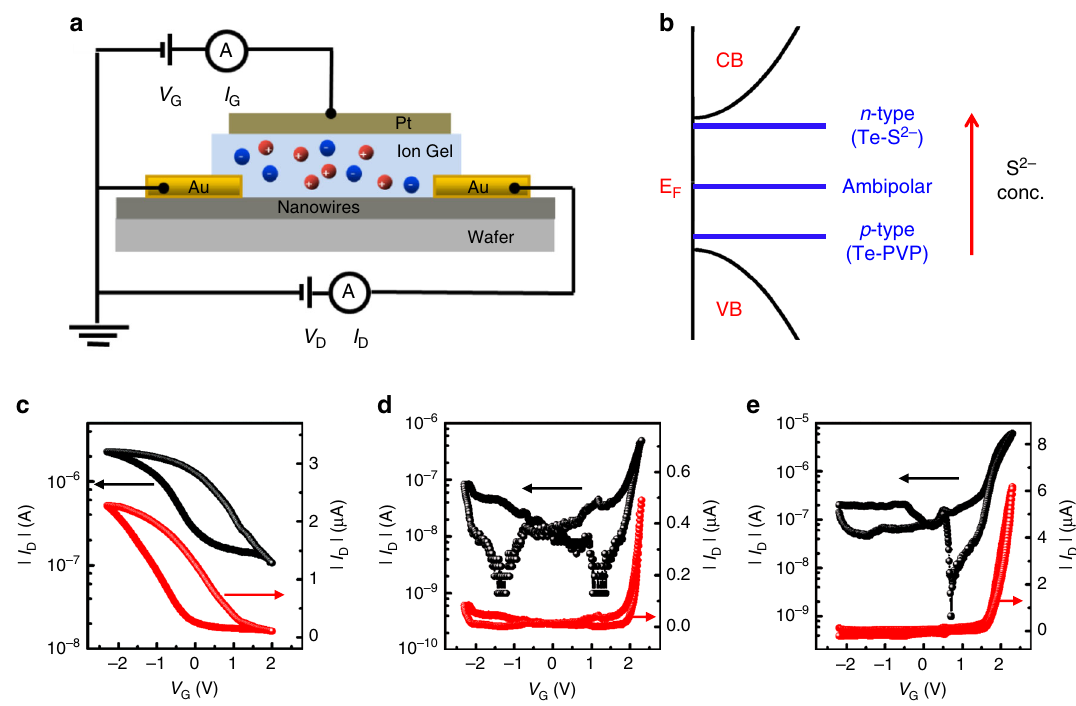
Fig. 5 Fermi level shifts with doping. a Schematic cross-section (not to scale) of ion-gel-gated thin- fi lm transistors used to characterize the electrical properties of the doped NWs. The length and width of the channel were 100 μ m and 2 mm, respectively. Red and blue circles represent positive and negative ions, respectively. b Energy level diagram depicting the relationship between the location of the Fermi energy ( E F ), band-edges, doping concentration, and corresponding nature of charge carriers. CB and VB refer to the conduction band and the valence band of Te, respectively. Transfer characteristics for the c undoped Te-PVP NW sample (with V D = 0.1V) showing p -type transport, d intermediate-doped Te NWs (~1.5% atomic concentration of sulfur, with V = − 0.3V) showing ambipolar transport. e Heavily doped Te NWs (~2.4% atomic concentration of sulfur, with V D Black and red curves plot the characteristics on logarithm and linear scales